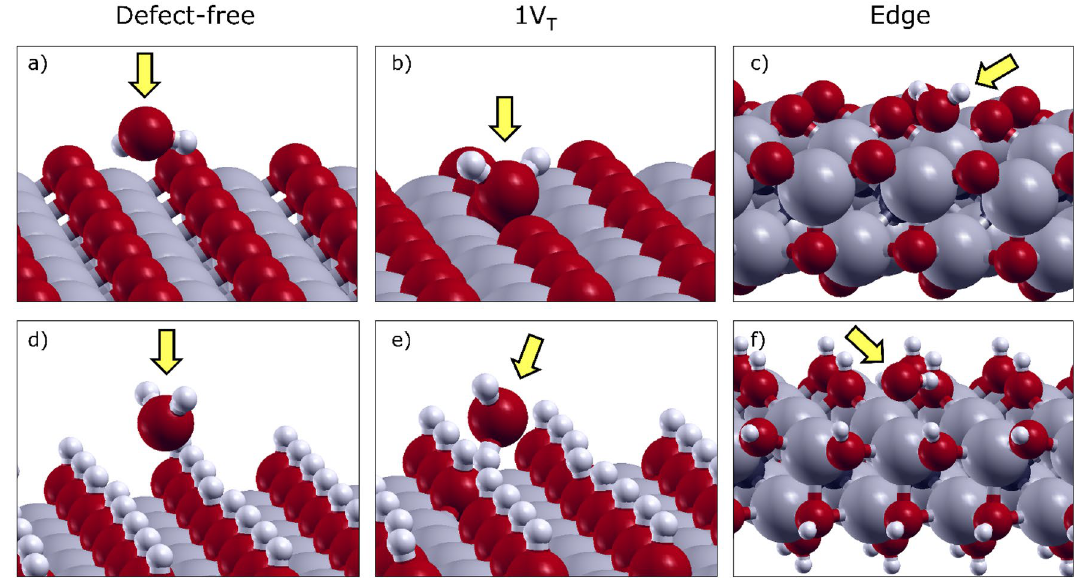
Fig. 3 Perspective view of the optimized configuration of H 2 O interacting with ( a , d ) defect-free MXenes, ( b , e ) surfaces with a vacancy of termination (V T ), and ( c , f ) edge of ribbons. Ti 2 CO 2 (above) and Ti 2 C(OH) 2 (below) are taken as examples. The yellow arrow highlights the presence of the water molecule. Ti atoms are shown in gray, O in red, C in black and H in